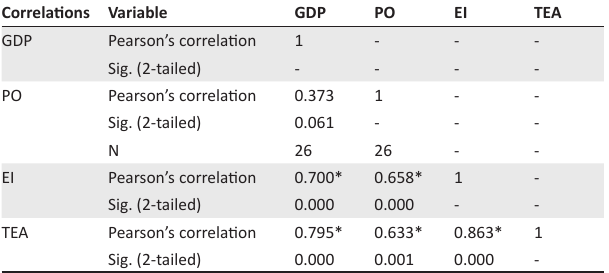
TABLE 1: Correlations between gross domestic product and total early-stage entrepreneurial activity (TEA), and TEA with perceived opportunity and entrepreneurial intentions in innovation-based